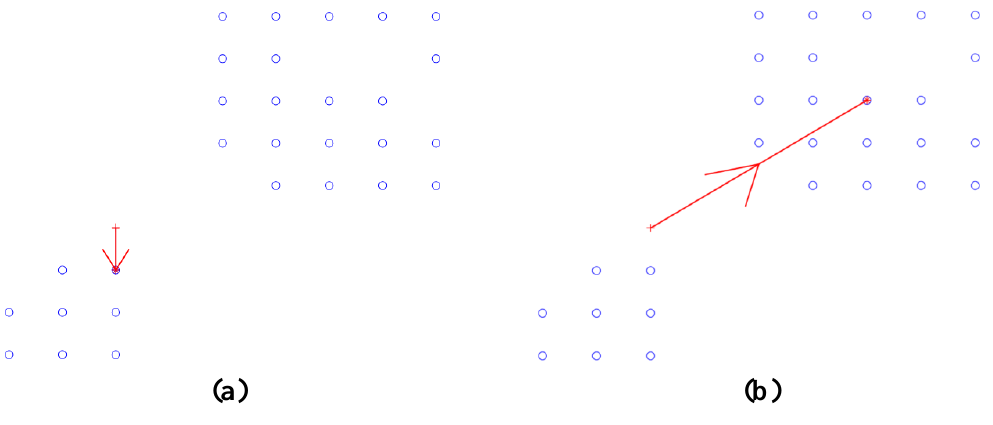
Figure 7. Navigation results of different methods. (a) Result of previous method; (b) Our